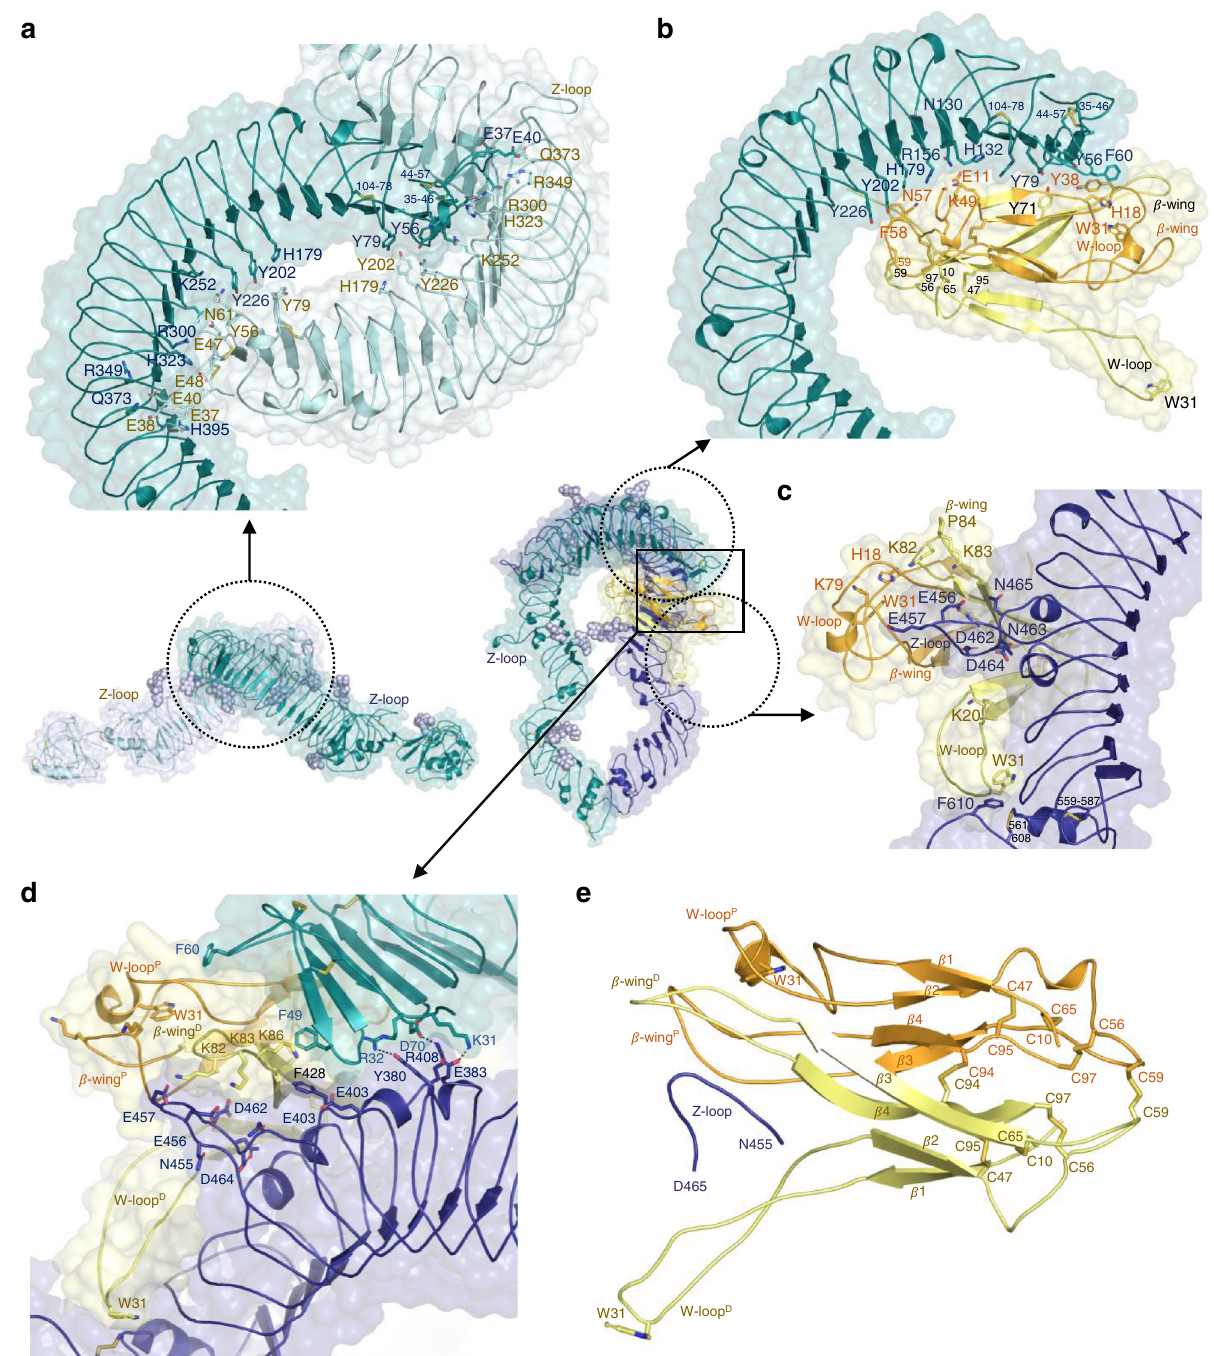
Fig. 2 | Ligand-induced asymmetry. a Close-up top view of the homodimer interface with N-terminal receptor-receptor interactions at LRRNT1-LRR14 and accessibleZ-loops. b Zoomed-insideviewSpz1CconcavebindingtoLRRNT1-LRR7. c Spz1C convex binding at the dimerization interface. Spz1C mediates extensive contacts between β -wings and the Toll5A Z-loop located between LRR14-LRR15 (Asn455-Asp465),withthedistalTrp-loopstabilizingthehingeregionbetweenLRR